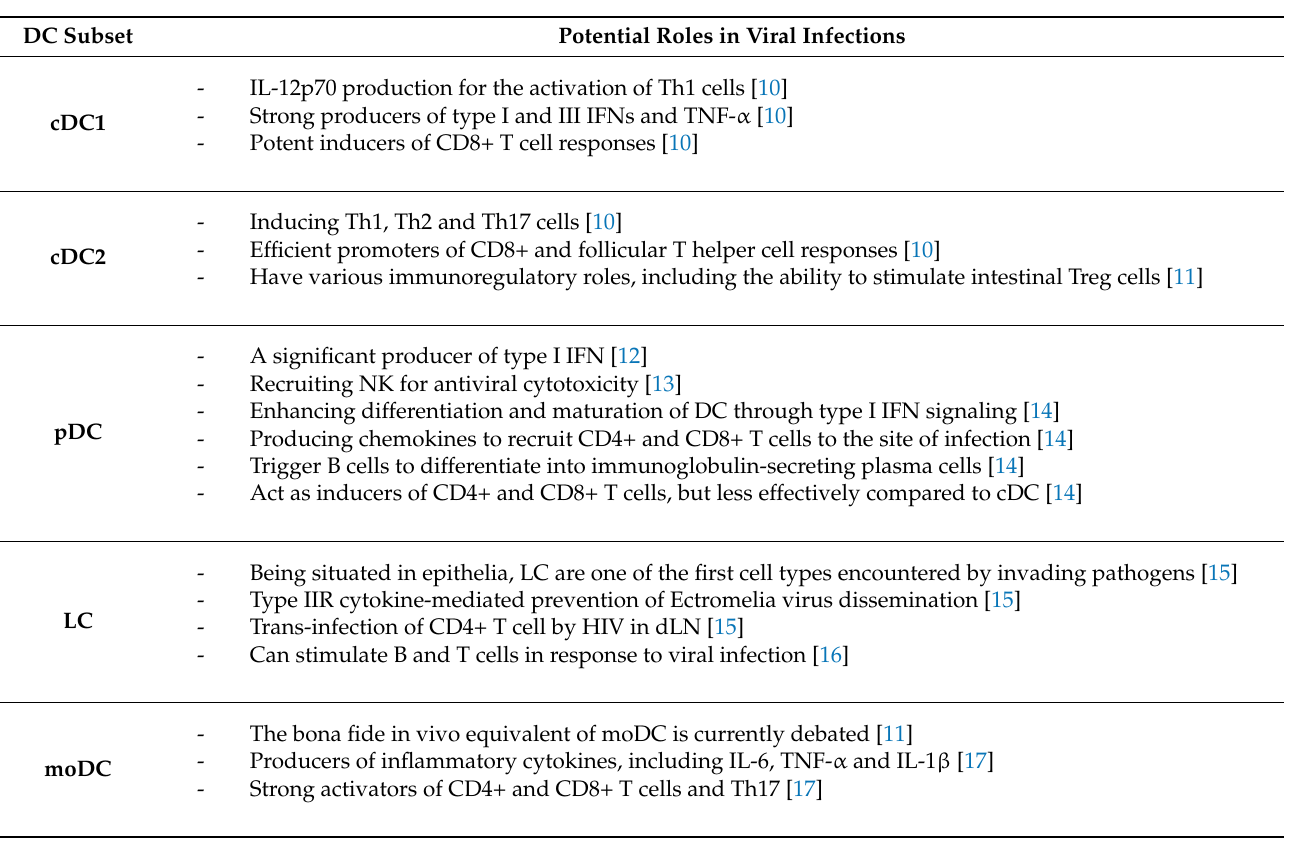
Table 1. Diverse roles of DC functions in different DC